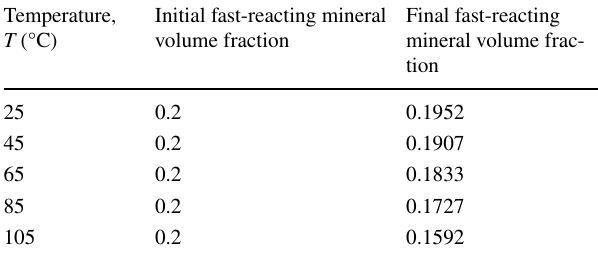
Table 8 Effect of temperature on fast-reacting mineral volume frac-